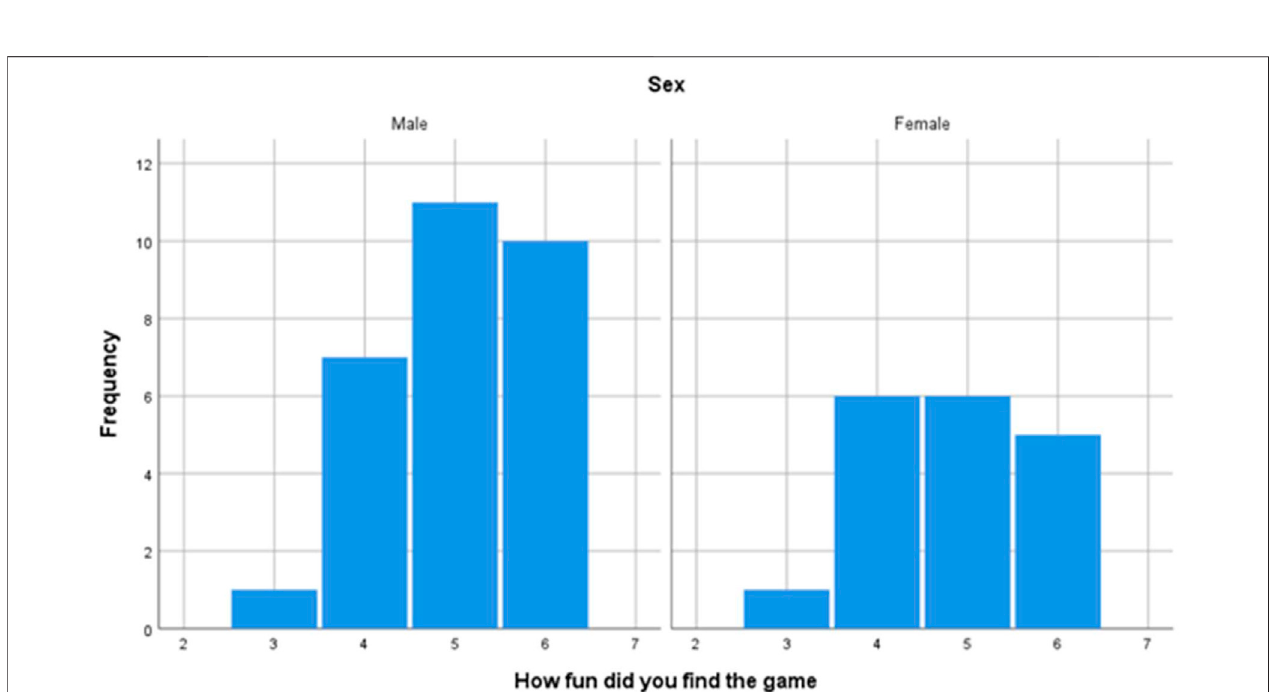
FIGURE 7 | Questionnaire participants results for how fun they found playing the game.